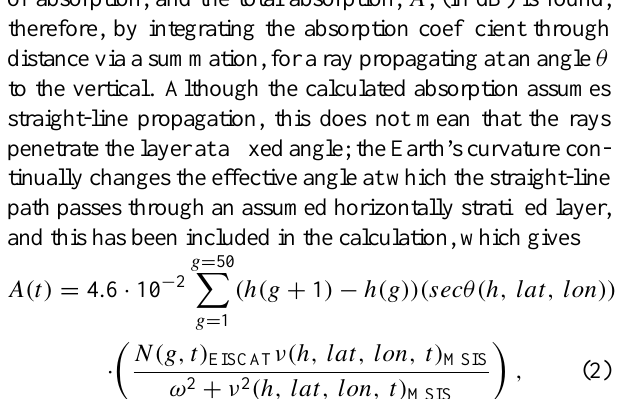
4 Analysis of HF propagation and